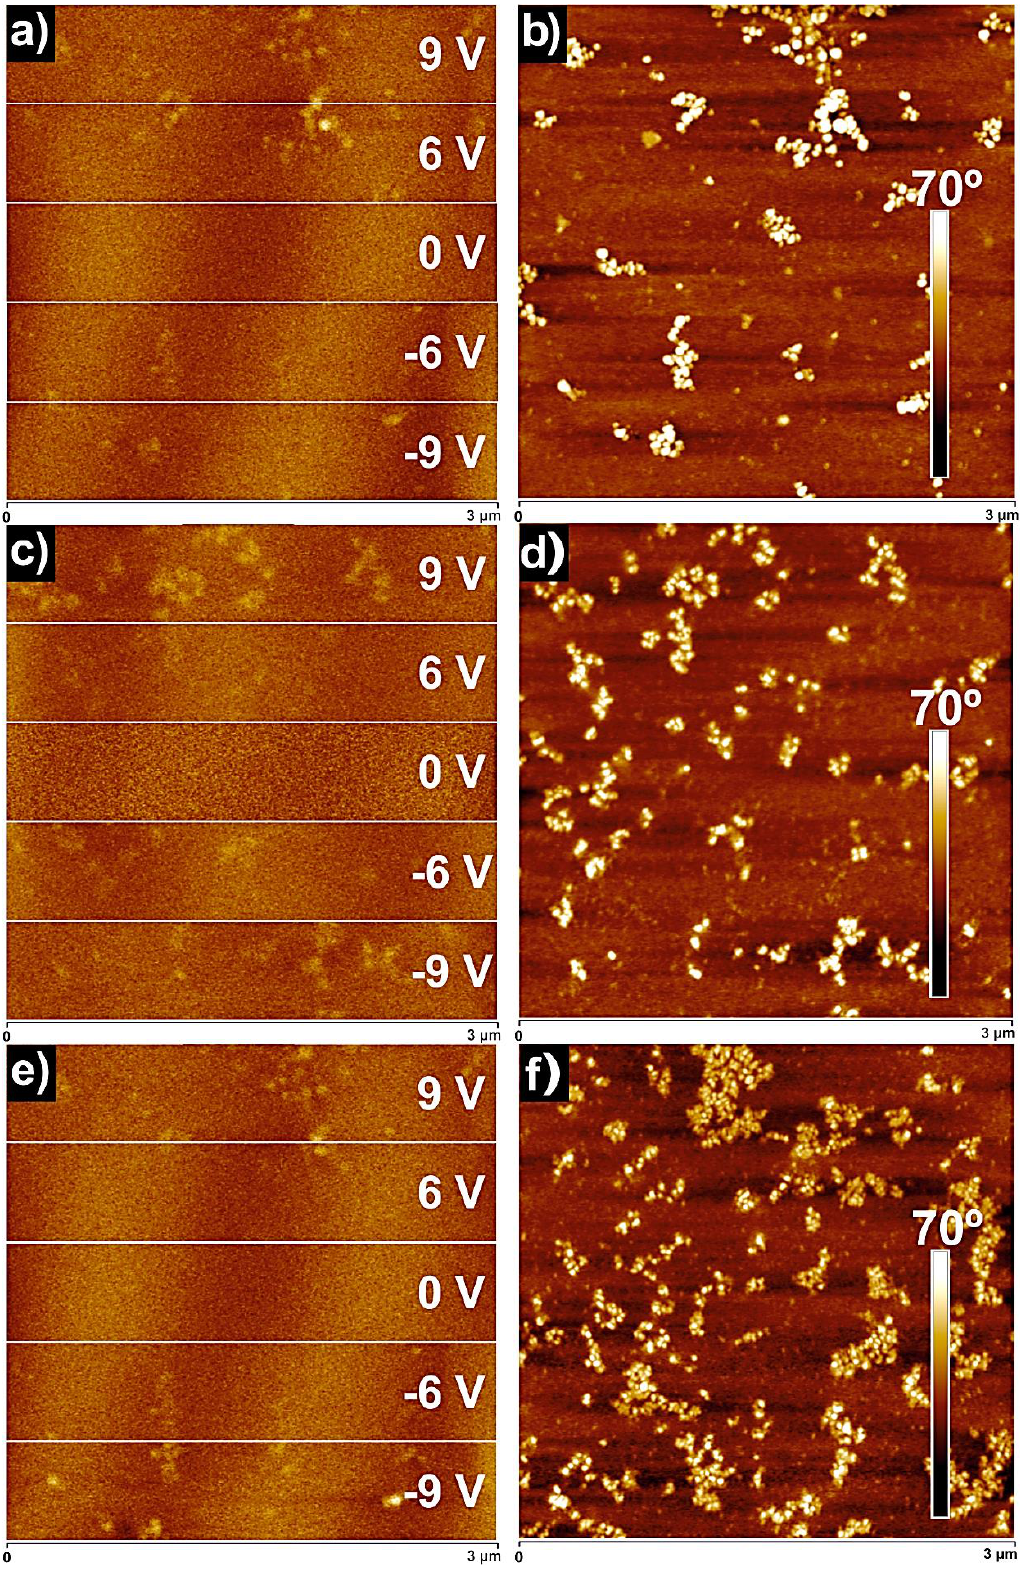
Figure 7. Electrostatic force microscopy (EFM) phase images (3µm × 3 µm) of ( a ) 10TiO 2 -PU0, ( c ) 20TiO 2 -PU0, ( e ) 40TiO 2 -PU0 and their simultaneously obtained AFM phase images (3µm × 3 µm). As expected, the locally charged TiO 2 nanoparticles were visualized in corresponding EFM images applying a bias of 6 and 9 V. Here, it should be mentioned that in the investigated TiO 2 -PU0 nanocomposites, the only conductive components were the TiO 2 nanoparticles [3]. An increase in the